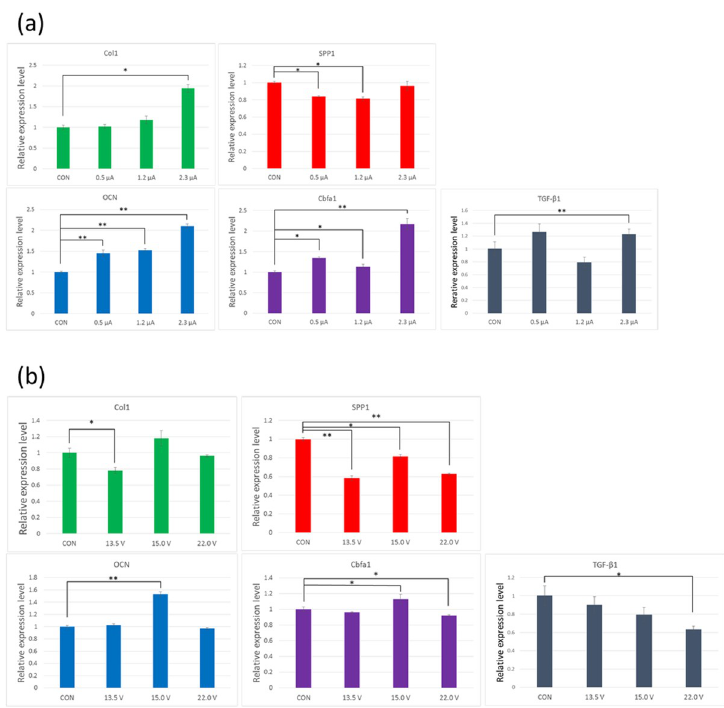
Fig 4. Gene expression of osteogenesis-related genes. (a) MC-3T3-E1 cells were subjected to EES for 2 days (Vd was fixed at 15.0 V and Ie was modulated). The mRNA levels of collagen I (Col1), osteopontin (Spp1), Ocn (osteocalcin), Cbfa1, and transforming growth factor beta 1 (TGF- β 1) were quantified by real-time PCR. The data points represent the mean value ± SD (n = 3), � p < 0.05, �� p < 0.01 vs. control (CON). (b) The experimental conditions were almost the same as those in Fig 3A except that Ie was fixed at 1.2 μ A and Vd was modulated.